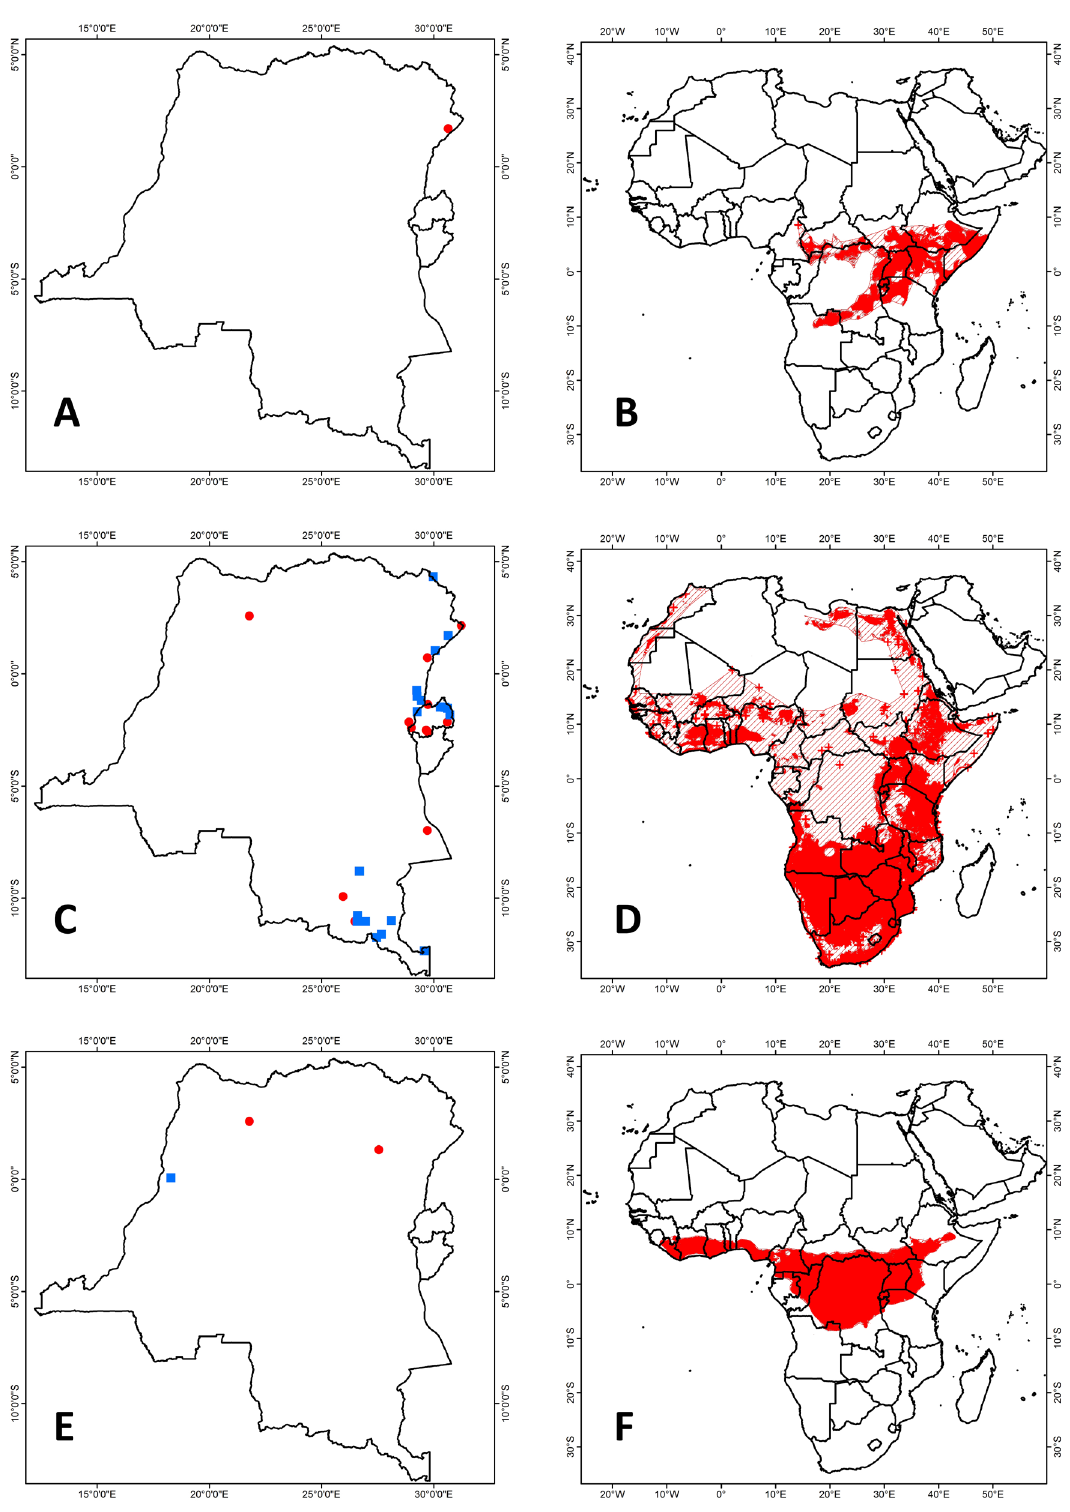
Fig. 23. Distribution maps. A–B . Nycteris parisii (de Beaux, 1924). C–D . Nycteris thebaica E.